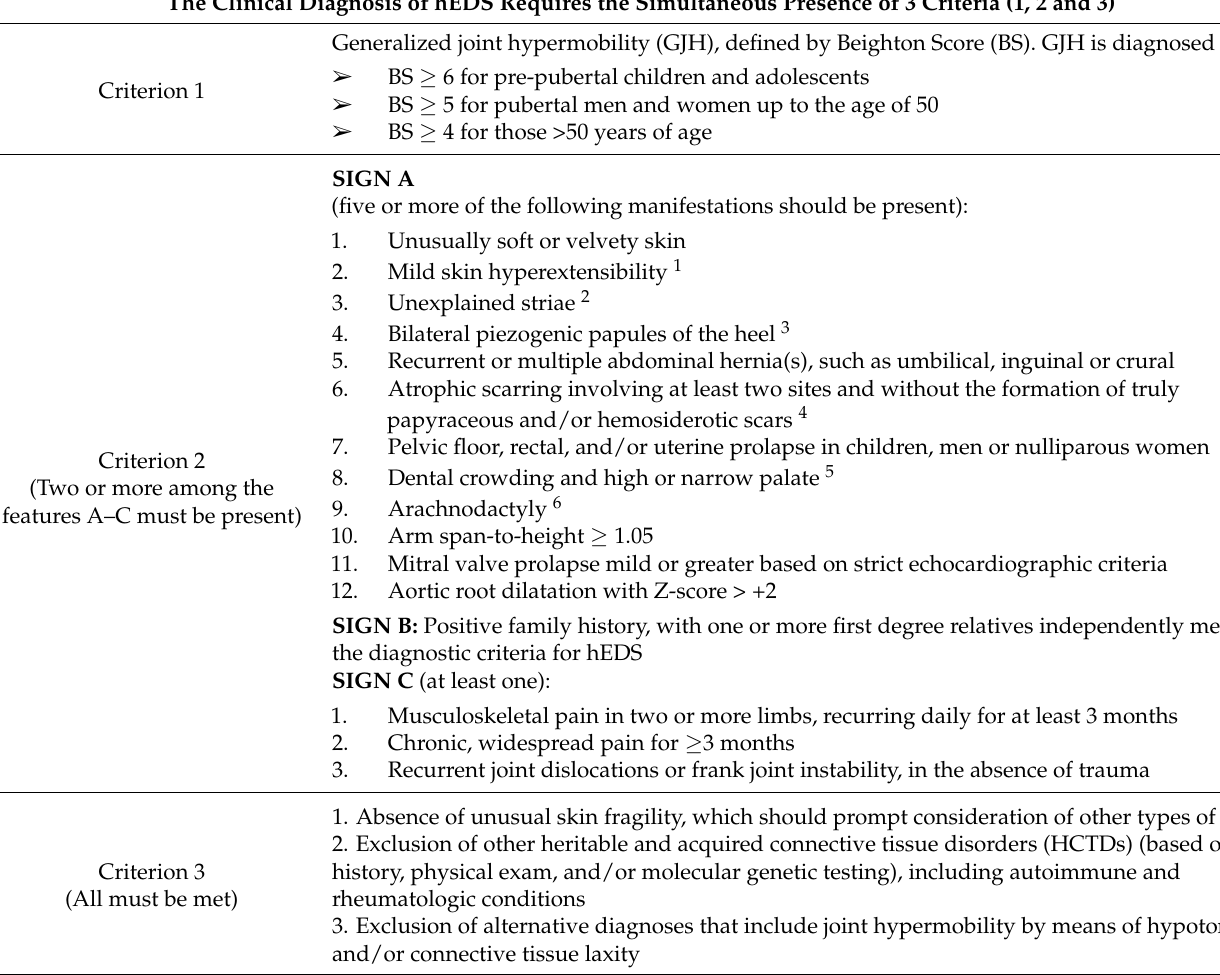
Table 2. Clinical Diagnosis of Hypermobile